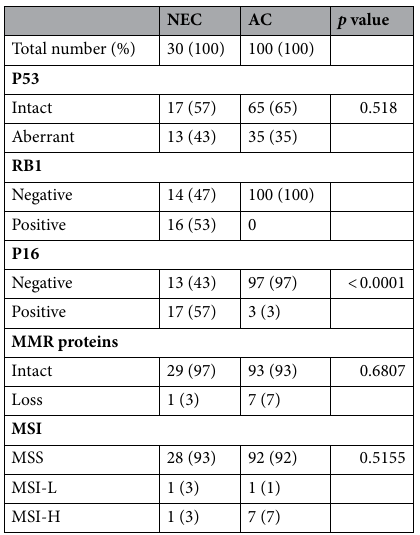
Table 2. Comparison of immunohistochemistry and microsatellite instability status between NECs and ACs. MMR mismatch repair, MSI microsatelllite instability testing, MSS microsatellite stable, MSI-L